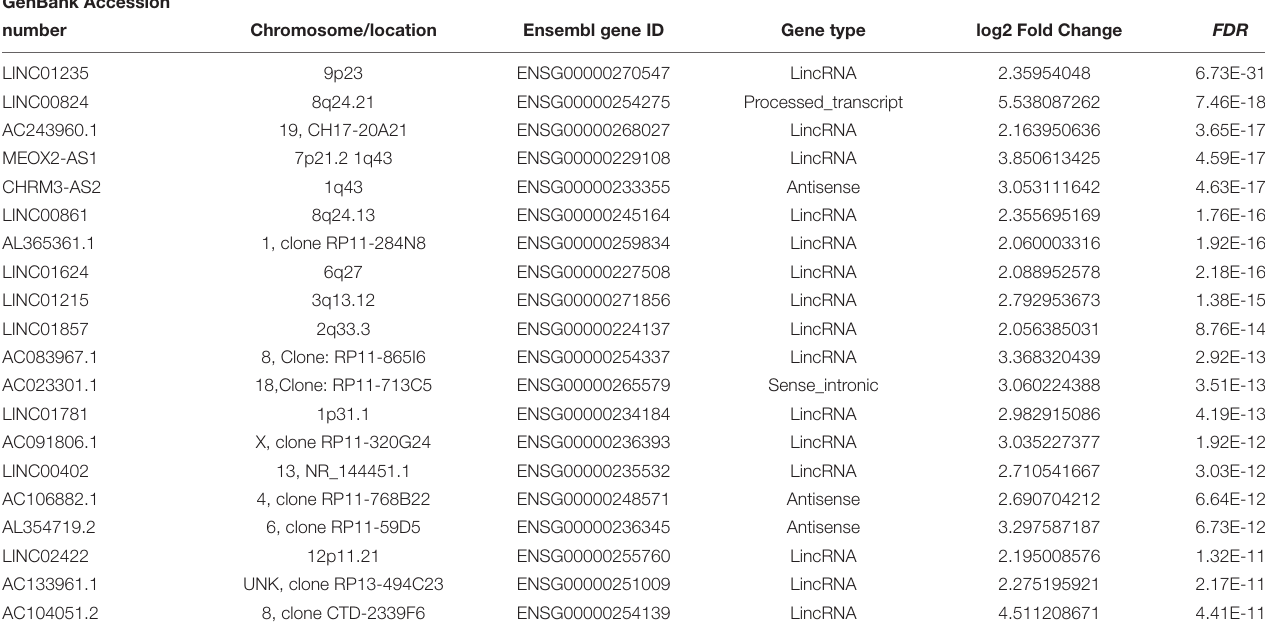
TABLE 1 | The top 20 upregulated DElncRNAs in metastatic melanoma ( p < 0.01).